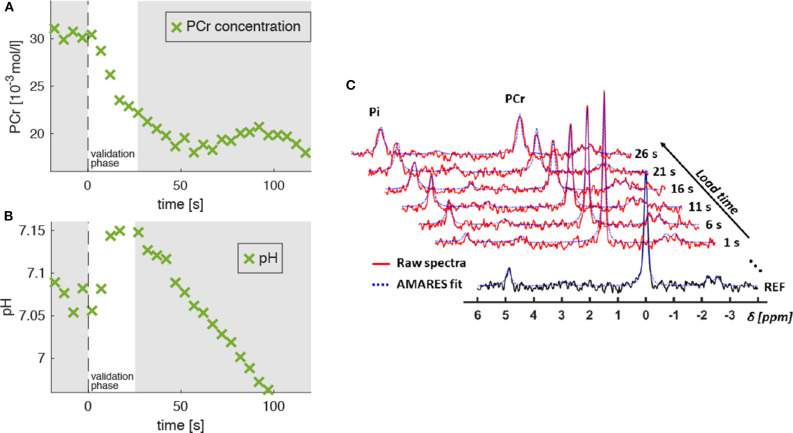
Evolution of PCr concentration ([PCr], A) and pH level (B) extracted from 31P-MR spectra, which were acquired in the M. gastrocnemius medialis during dynamic plantarflexion exercise (experiment 3, section 2.3). The time point t = 0 s marks the onset of the exercise. Highlighted is the validation phase (t = 0…25 s) for which we hypothesized agreement between experiment and model. During this phase, the PCr concentration reveals a continuous decrease indicating ATP re-synthesis and, thus, energy consumption in the muscle (see section 2.4). During the validation phase the energy supply is dominated by the PCr depletion. The pH decrease for t > 25 s reflects the H+ accumulation during the anaerobic glycolysis. Subplot (C) shows the raw spectra (red graphs) and corresponding AMARES fits (blue dashed graphs), obtained during the validation phase. The black graph in the sublot (C) shows a spectrum obtained prior to exercise.